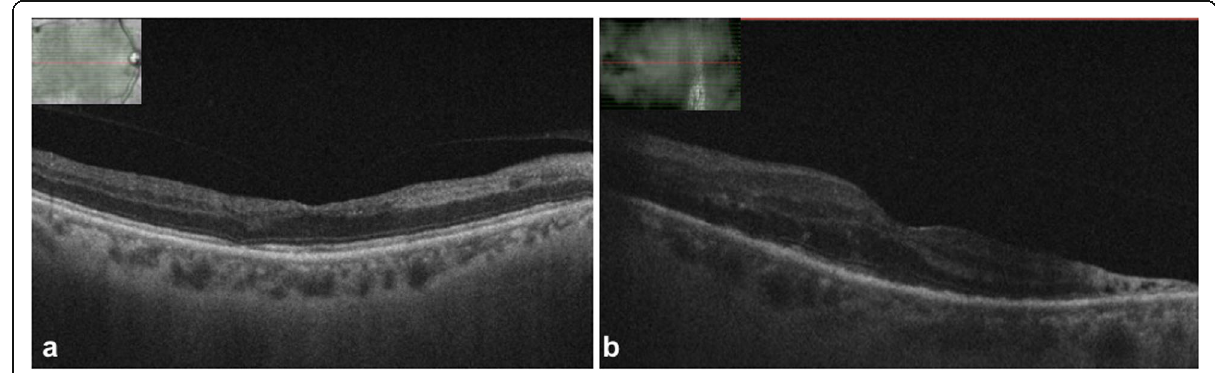
segment atrophy with ellipsoid (photoreceptors) loss